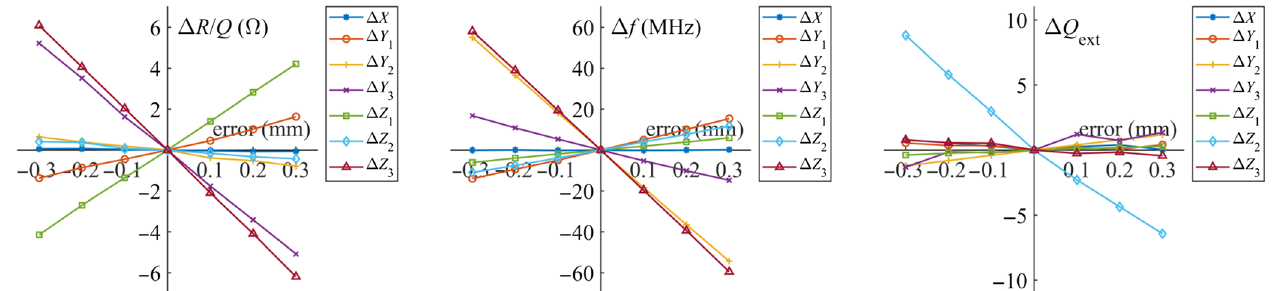
FIG. 5. rf parameter variations of TM 110 mode from the tolerance analysis.